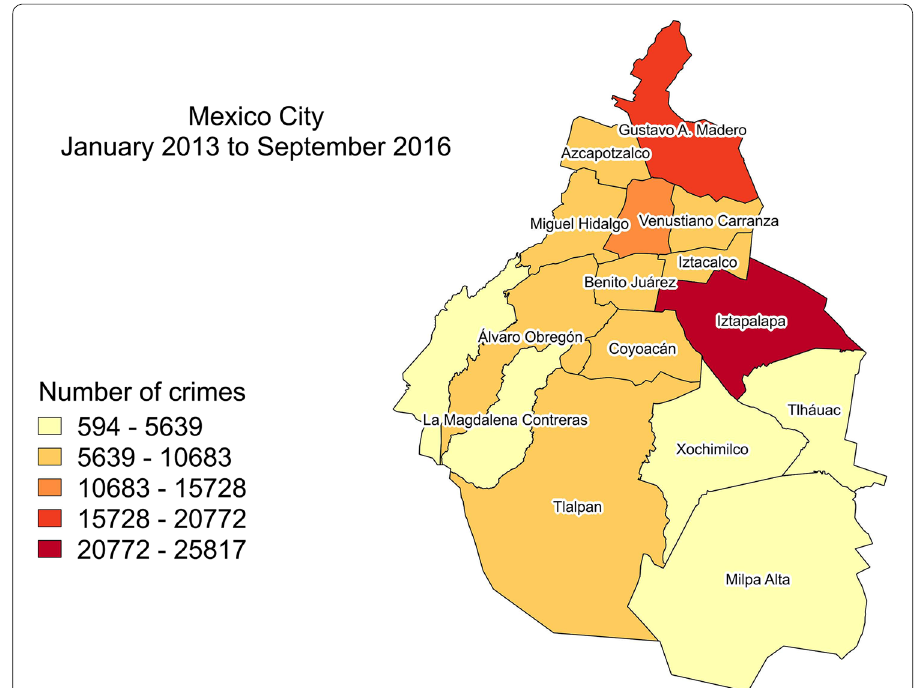
Fig. 1 Number of crimes per borough in Mexico City